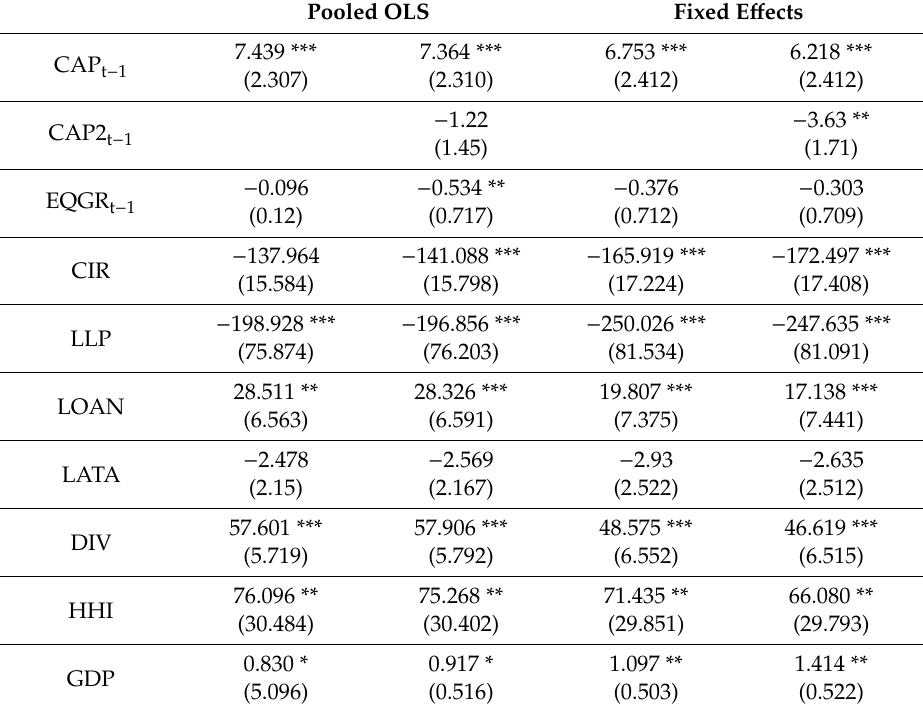
Table 4. Capital structure and bank profitability (ROE): OLS and fixed-e ff ects